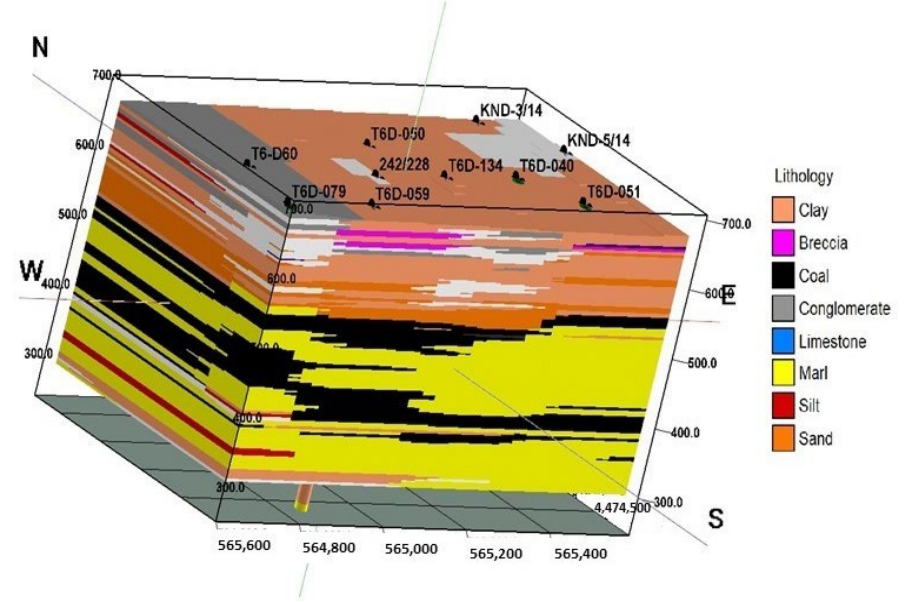
Figure 11. High-resolution 3D lithological block model in the suggested area according to UCG criteria. Vertical axis represent a.s.l values.